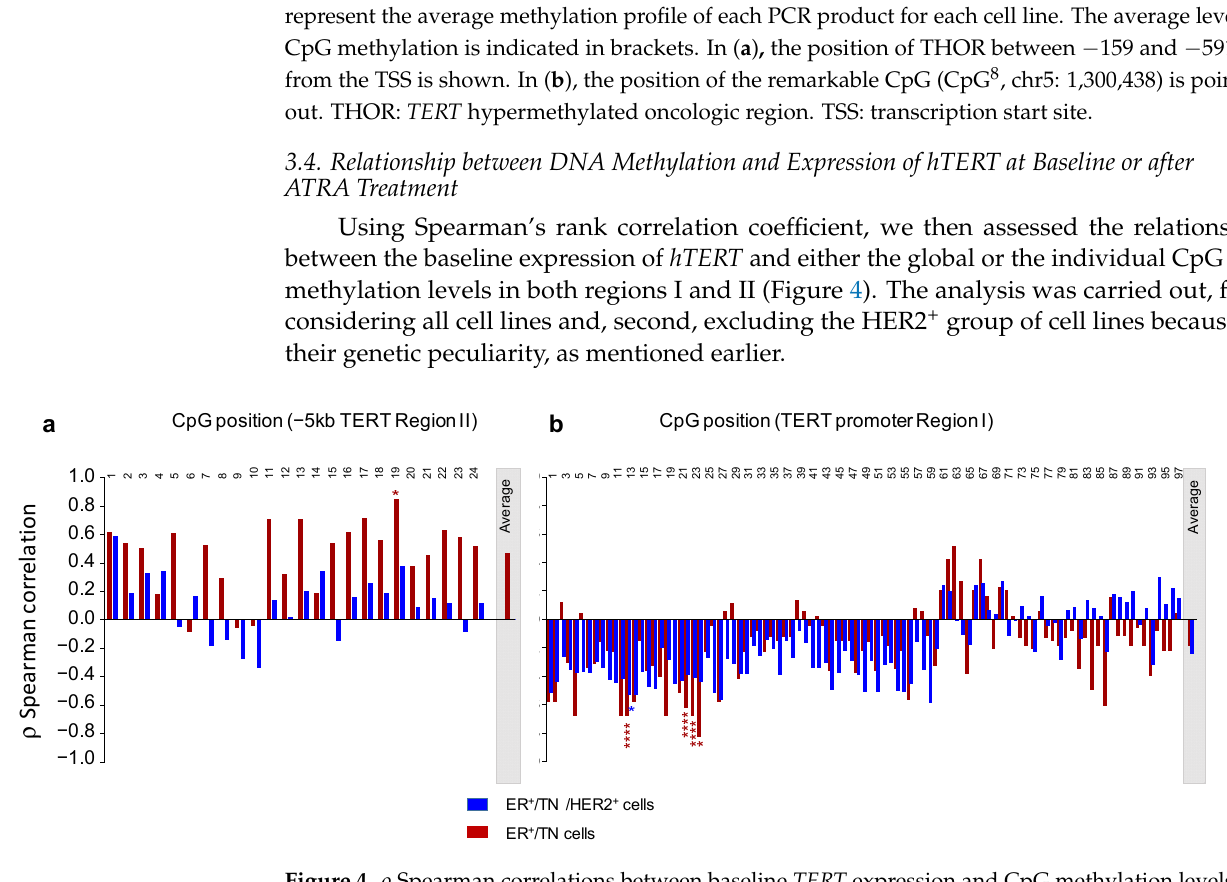
ER + /TN /HER2 + cells ER + /TN cells Figure 4. ρ Spearman correlations between baseline TERT expression and CpG methylation levels for either TERT region II ( a ) or TERT promoter region I ( b ). Blue bars: analysis performed considering all cell lines. Red bars: HER2 + cells were excluded from the analysis. CpG positions of each studied region are indicated. “Average”: the average DNA methylation level for each region is specified in the grey box. Corresponding p -values are shown with each bar: * p < 0.05; **** p <